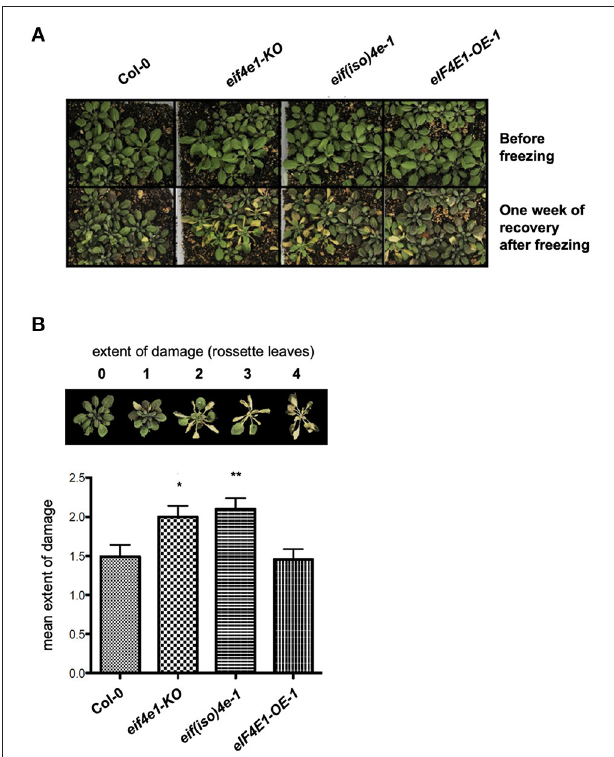
FIGURE 3 | The absence of eIF4E1 or eIF(iso)4E reduces the freezing tolerance of 5-week-old Arabidopsis plants. (A) Plant phenotypes were registered before freezing, and after 1 week of recovery upon freezing exposure for 1 hour. Col-0, wild type; ateif(iso)4e-1 , knockout eIF(iso)4E mutant; eIF4E1-KO , knockout eIF4E1 mutant; AteIF4E1-OE , plants expressing eIF4E1 under the CaMV 35S promoter. (B) Mean values of damage extent were calculated after registering the phenotype of 60 plants per line in five biological replicate experiments, according to the scale shown above the graph. Significant differences were evaluated by one-way ANOVA followed by Dunnett test; * p < 0.05, ** p < 0.01.